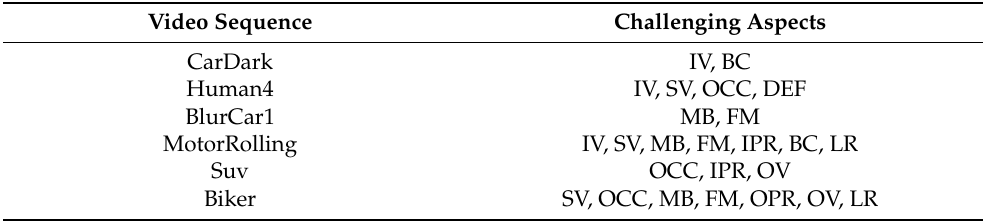
Table 2. Testing sequences and their challenging